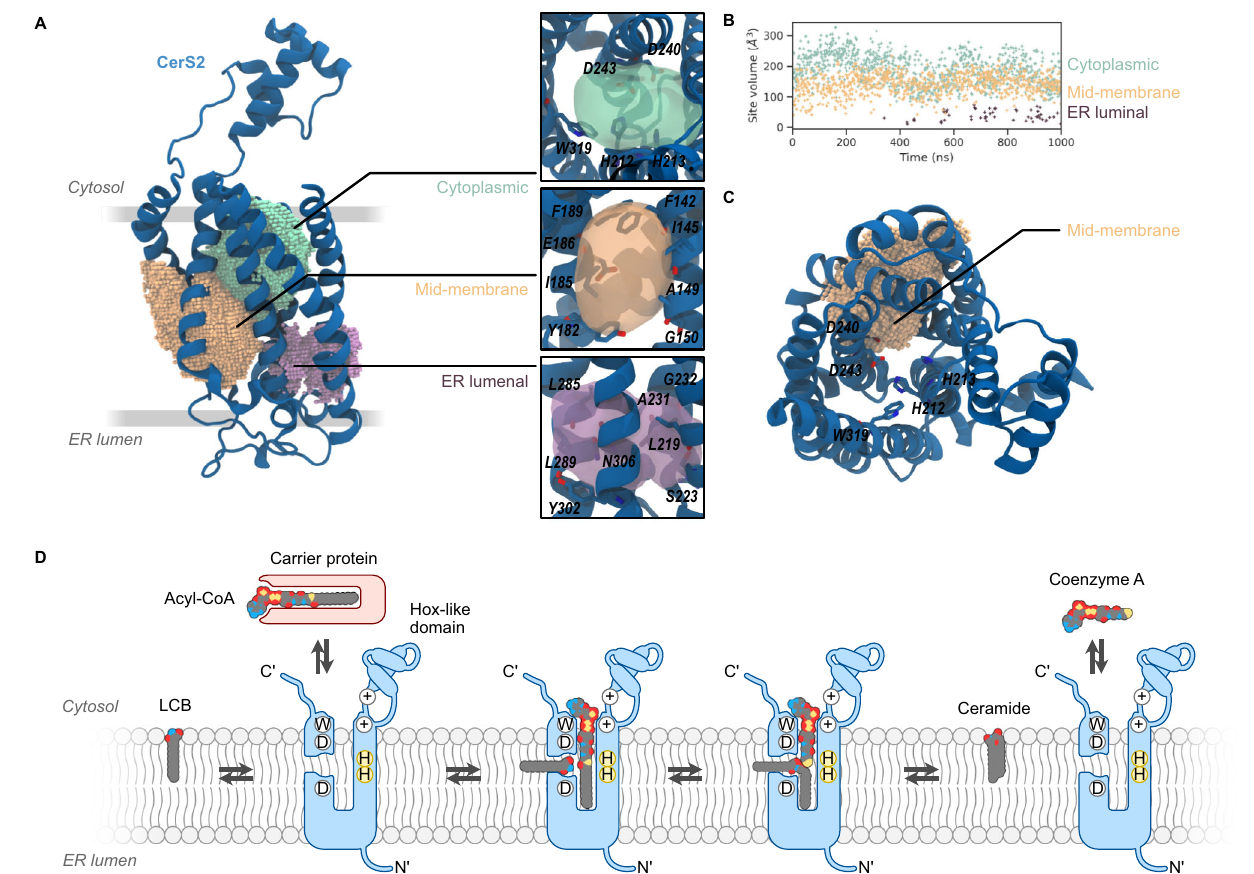
Fig. 3 | MDsimulationsofCerS2 revealputativebinding pocketsand suggest a working model for N -acyltransferase activity. A The three pockets in the cyto- plasmic ( green ), mid-membrane ( orange ), and ER lumen ( purple ) are shown as spheresbasedonSiteMappocketpredictions.Theinset( right )depictstheposition of the three pockets as translucent isosurfaces with selected residues labeled and shownasstickswithper-atomcoloring. B Volumeofpocketsplotted versus timeof simulation. Vertical axis shows cavity volume (Å 3 ). Source data are provided as a Source Data fi le. C Verticalview ofCerS2 with the mid-membrane pocketshown as spheres. Highly conserved residues lining the predicted active site are labeled. D Working model for CerS N -acyltransferase activity. The CerS active site accom- modates an acyl-CoA, which is delivered from the cytoplasmic side of the ER